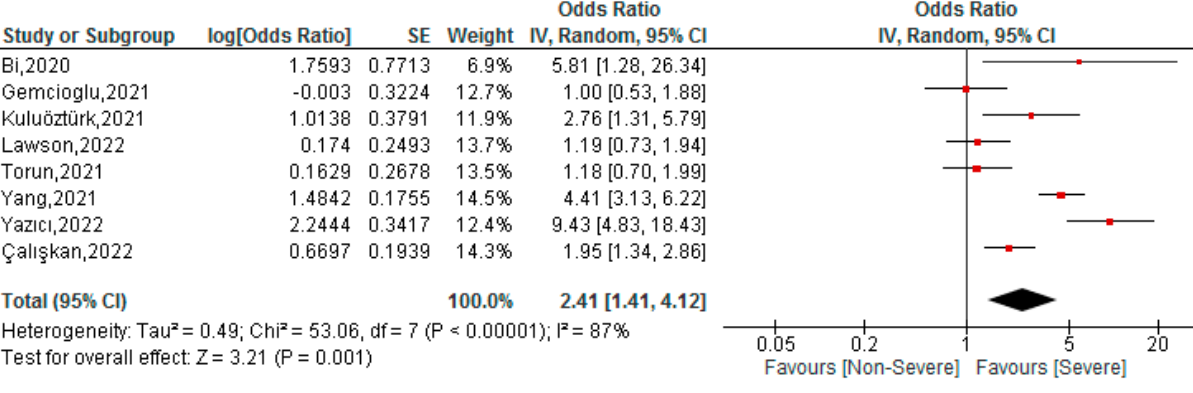
Figure 2. Association between FAR and severity of COVID-19 patients [33,34,36,39 − 41,50,52].